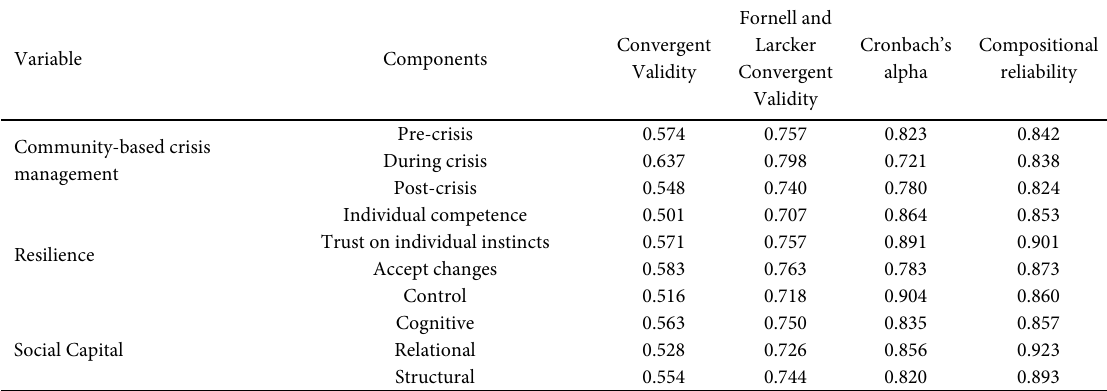
Table 1: Questionnaire validity and reliability factors